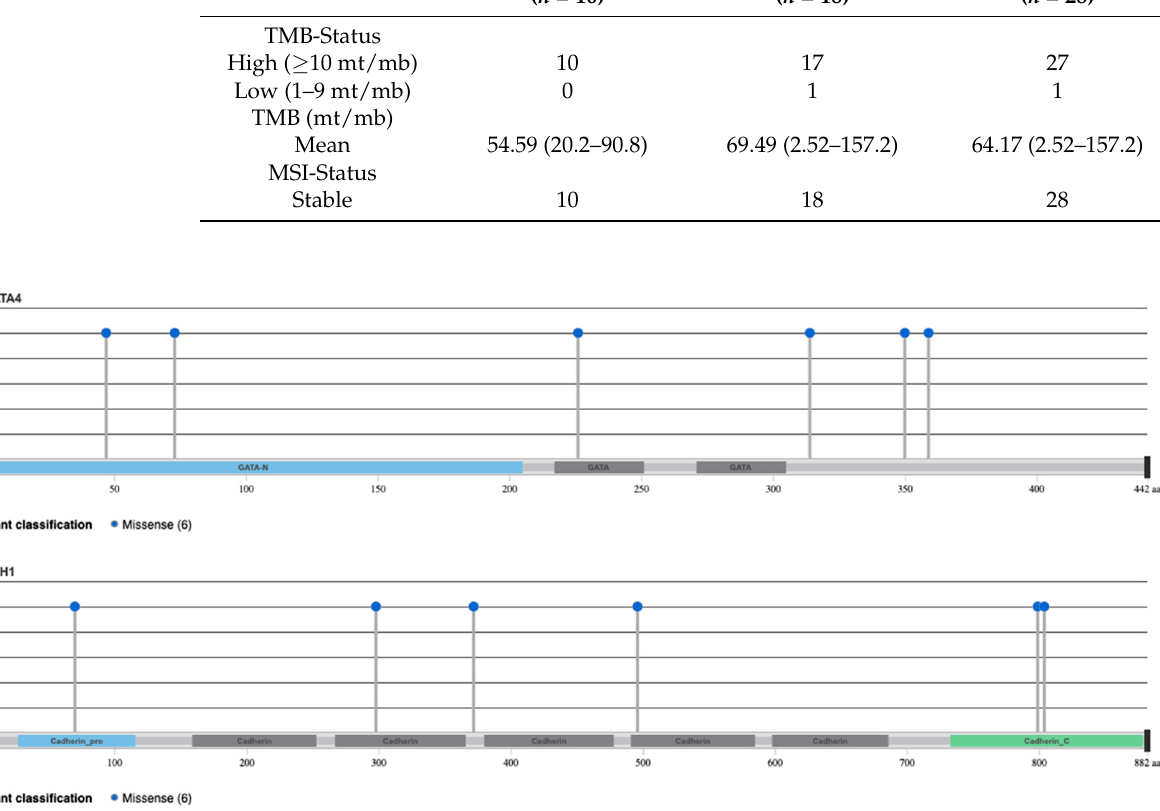
Figure 7. Lollipop plots highlighting genomic alterations of unknown mutations in selected genes: ( a ) GATA4A (GATA binding protein 4) and ( b ) CDH1 (cadherin 1) in AFX and PDS. Blue circles are indicating truncating mutations. The height of the line represents the number of mutations at the specified position. The grey bar represents the entire protein with the different amino acid positions (aa). The coloured boxes are specific functional domains.